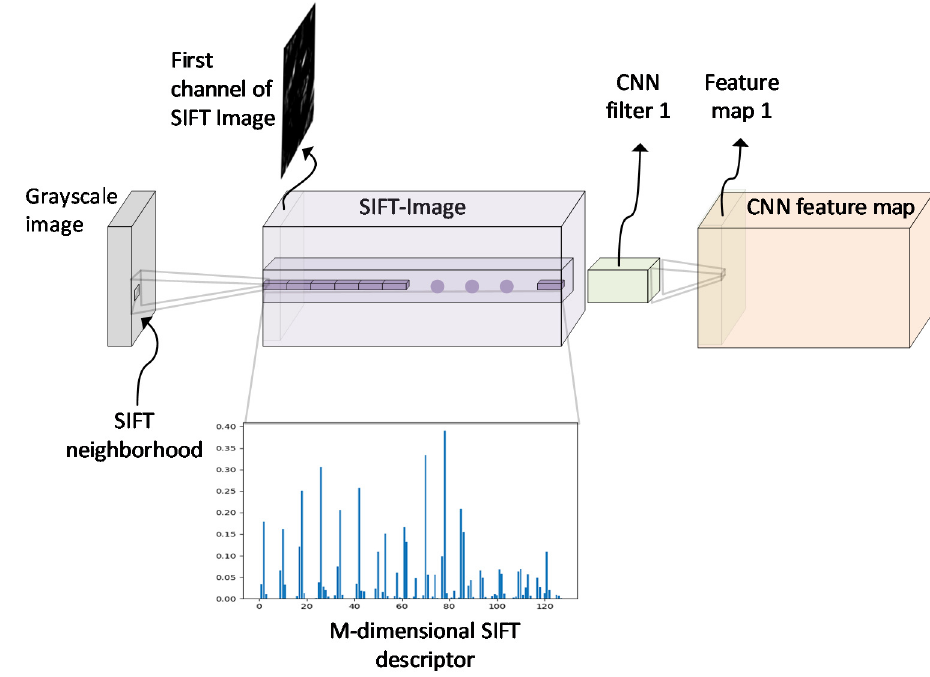
Figure 3. Given a grayscale image, one SIFT descriptor is computed for each pixel of the image that captures a neighborhood around every pixel. Thus, each pixel is mapped to an M = 128-dimensional SIFT descriptor. For all the pixels in the grayscale image, the corresponding result is a new image that is called a SIFT image. The SIFT image is created with the SIFT descriptors for all the pixels of the grayscale image. Therefore, the SIFT image has the same spatial size as the grayscale image, and M = 128 channels are equal to the dimension of a SIFT histogram representation. In the SIFT-CNN framework, every input convolutional layer of the CNN (e.g., CNN filter 1) operates directly on the SIFT image, such as in a multiscale input image, with the regular convolution process. In this way, the output of the first convolutional layer is an ordinary CNN feature map. After all, the utilization of SIFT images as inputs supplies the CNN with the local rotation invariant property. This property is immanent in the SIFT descriptors and is implicitly incorporated into the CNN model via data-driven training.